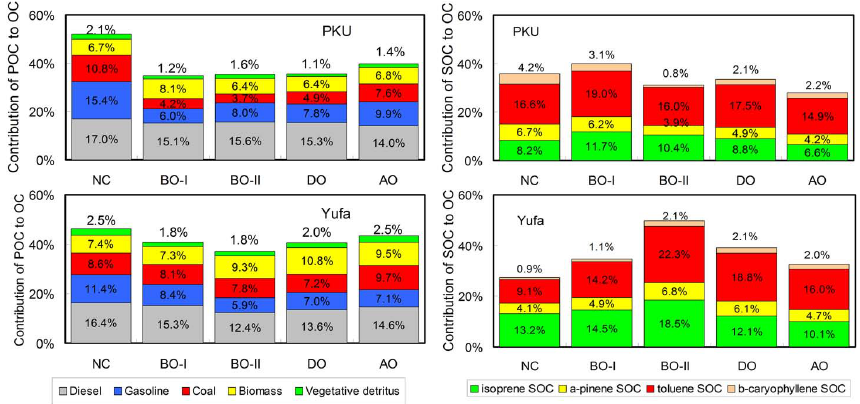
Fig. 2. Contribution of primary and secondary sources to measured PM 2 . 5 OC during different periods. NC=not-fully-controlled, BO=before Olympics, DO=during Olympics, AO=after